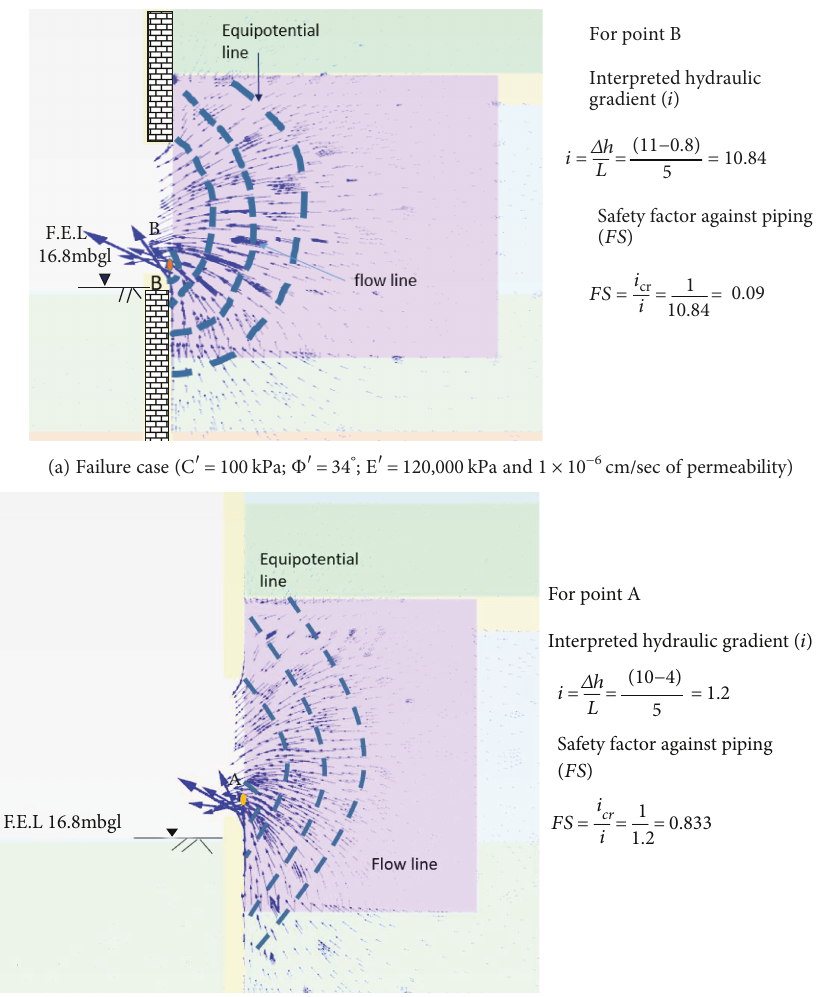
Figure 13: Schematic drawing of fl ow net and safety factor against piping